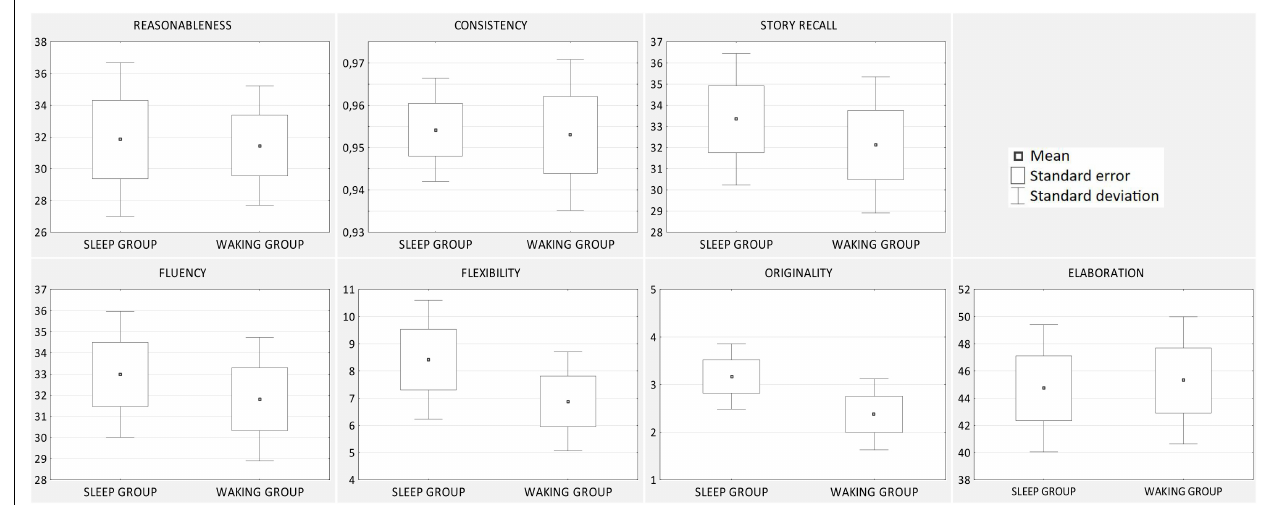
FIGURE 2 | Effects of sleep on problem solving. Differences between sleep and waking group in task performance (means, standard errors, and standard deviations).